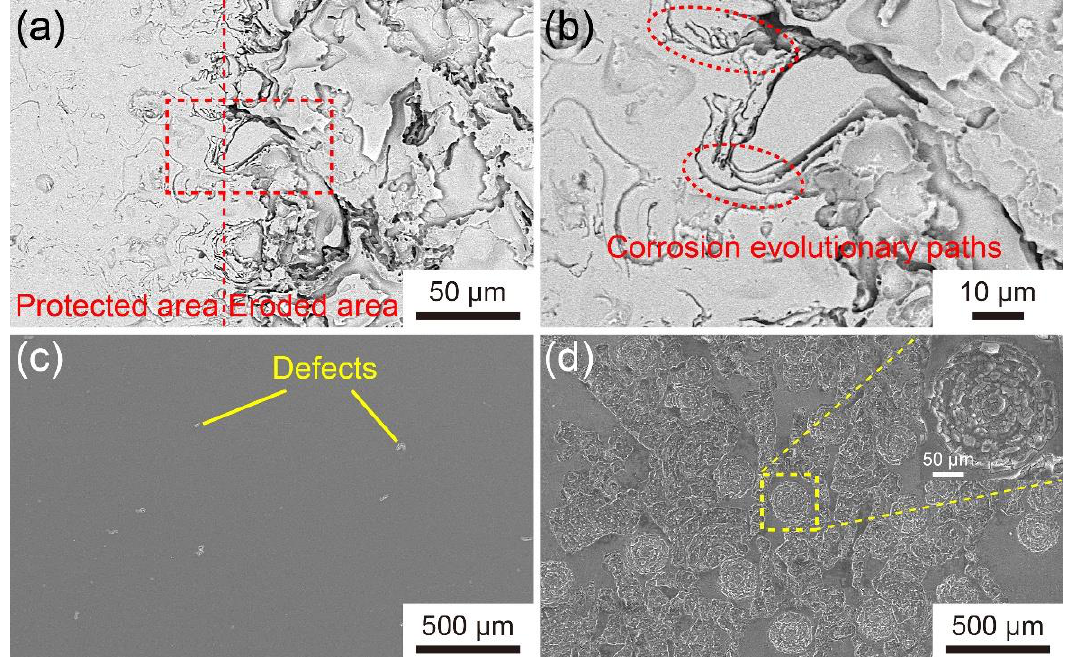
Figure 10. SEM image with low ( a ) and high ( b ) magnification of the protected area and eroded area on Coating D after potentiostatic polarization at 1.3 V SCE for 30 min in 3.5 wt.% NaCl solution; ( c ) SEM image of the uncorroded surface of LA141 magnesium alloy, ( d ) SEM image of the corroded surface of LA141 magnesium alloy after immersion in 3.5 wt.% NaCl solution at the open circuit potential for 30 min. Inset in ( d ) is higher magnification SEM micrograph of pitting.